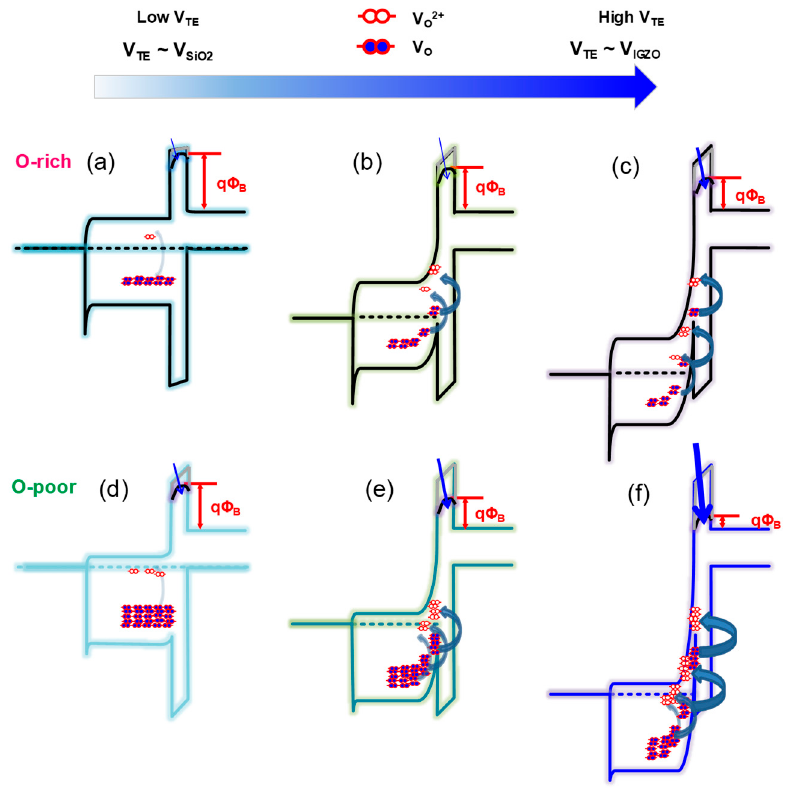
Figure 5. The OFR-dependent energy band diagram and Φ B with ( a )–( c ) high OFR and ( d )–( f ) low OFR at ( a , d ) thermal equilibrium, ( b , e ) low V TE , and ( c , f ) high V TE .